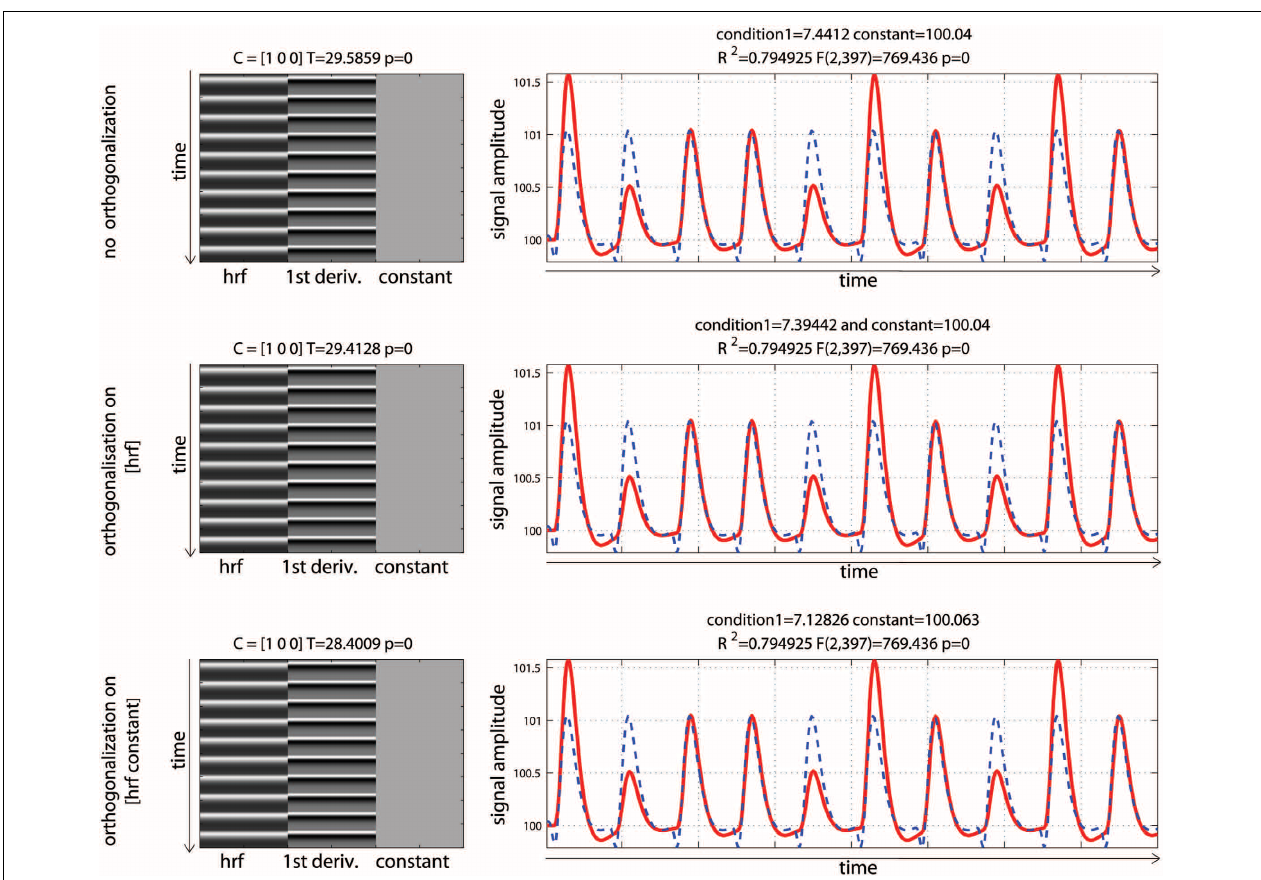
FIGURE 5 | Periodic event related designs with 1 condition with a temporal shift of 2s between the model and the data. From top to bottom , data are modeled using the hrf and 1st derivative without orthogonalization, using the hrf and 1st derivative with orthogonalization on the hrf only, and the hrf and 1st derivative with orthogonalization